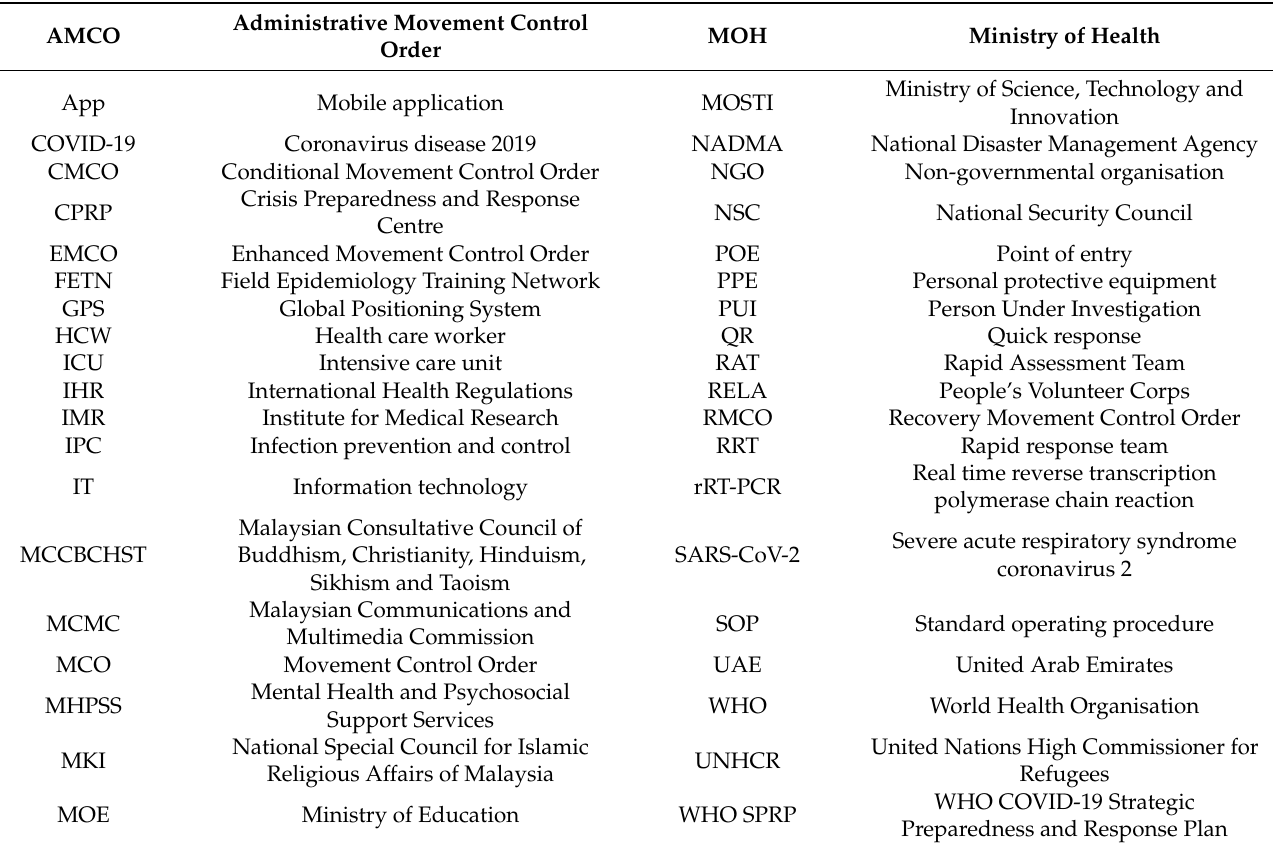
Table A4. Abbreviations used throughout the